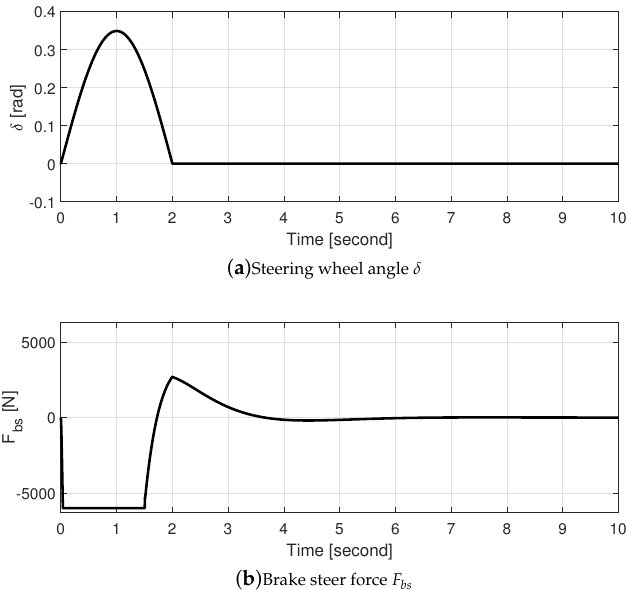
Figure 6. Vehicle and camera models used in the simulations